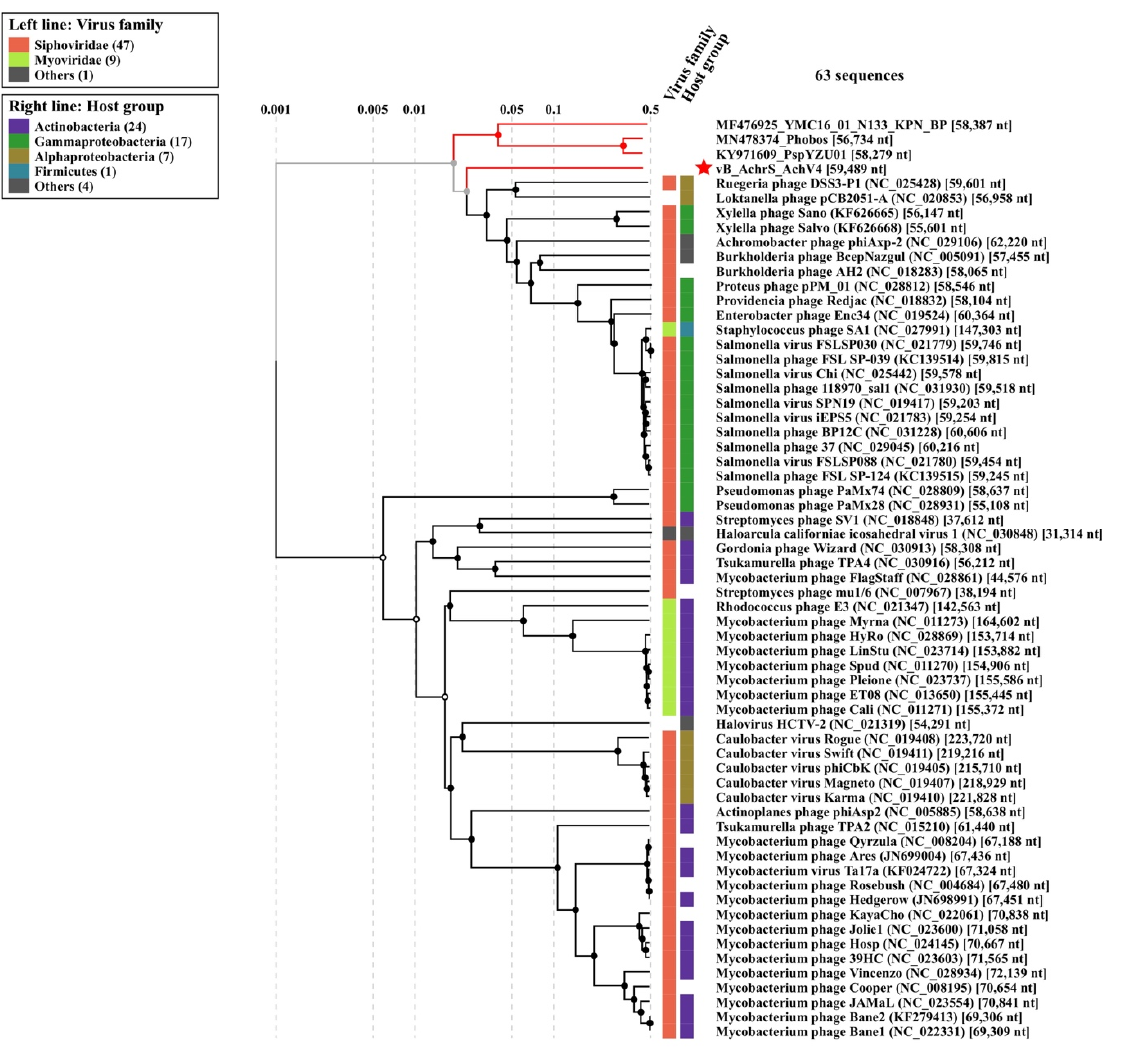
Figure 5. Phylogenetic analysis based on genome-wide sequence similarities computed by tBLASTx. The proteomic tree based on the complete genome sequences of phages with S G values to AchV4 ranging from 0.1581 (Phobos) to 0.05 (Mycobacterium phage JAMaL). The figure was generated by ViPTree.